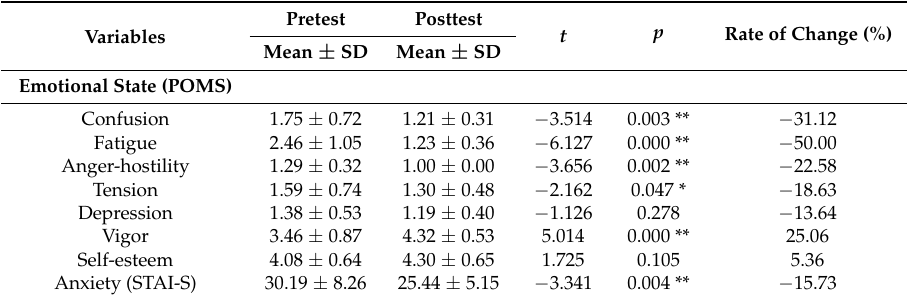
Table 2. Effect of the forest therapy program on emotional state and anxiety. Variables